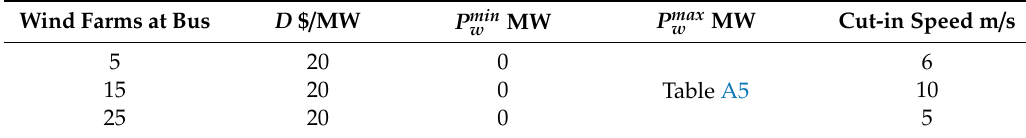
Table A3. Cost coe ffi cient profile of windfarms.